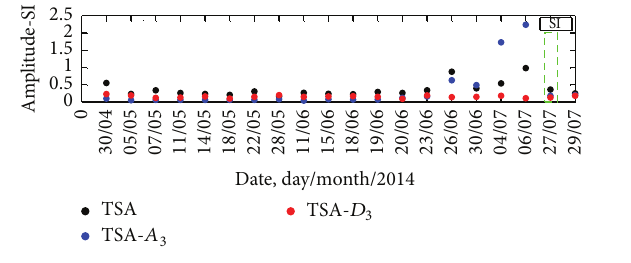
Figure 11: FM4 ∗ over RDLT.